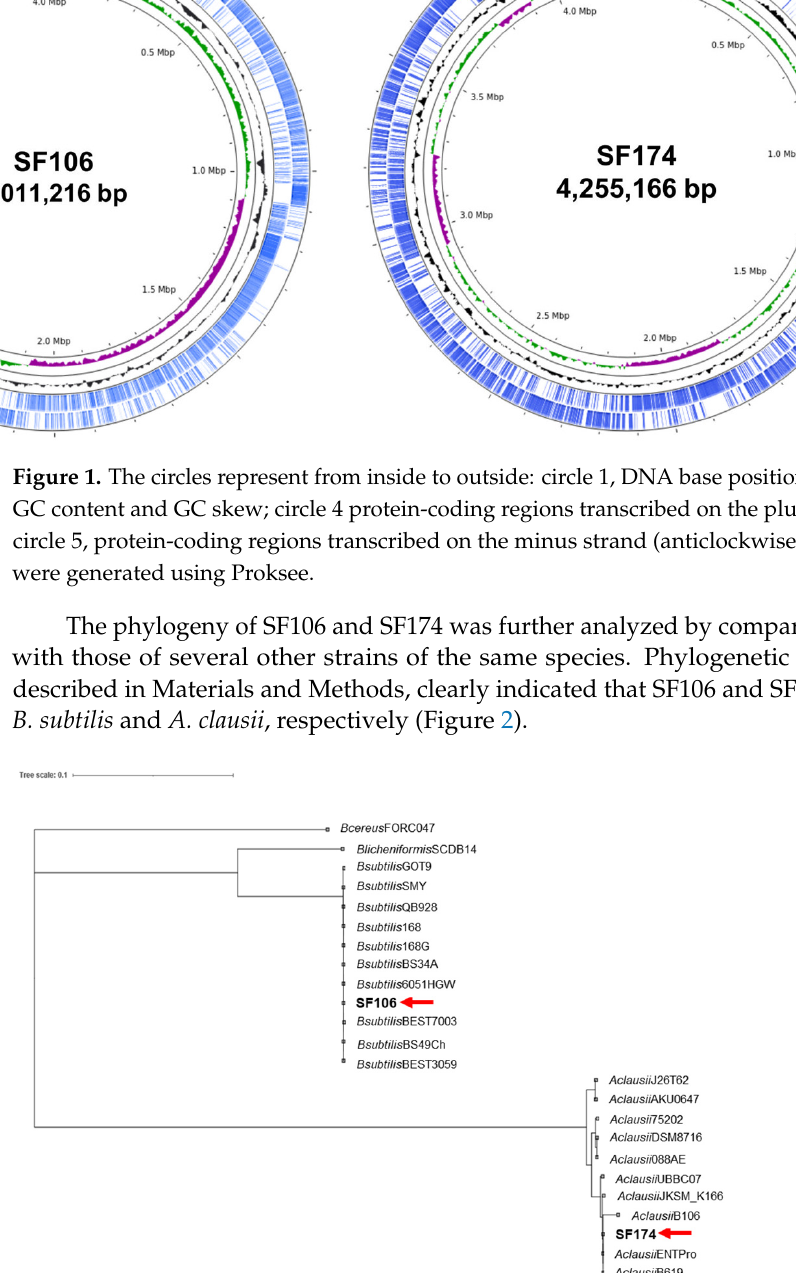
Figure 1. The circles represent from inside to outside: circle 1, DNA base position (bp); circle 2 and 3, GC content and GC skew; circle 4 protein-coding regions transcribed on the plus strand (clockwise); circle 5, protein-coding regions transcribed on the minus strand (anticlockwise). The genome plots were generated using Proksee. Table 1. General features of the SF106 and SF174 genomes.